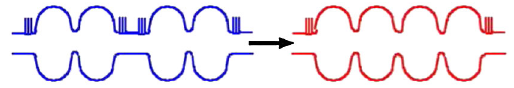
FIG. 10. (Color) Doubling of the cell